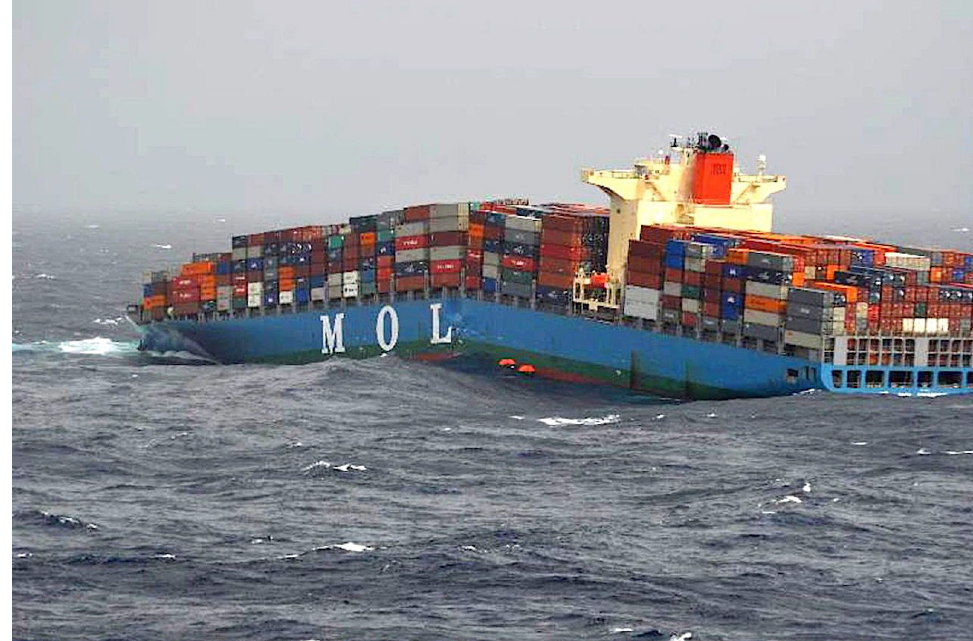
Figure 30. Breakup of the container ship MOL Comfort, off Yemen, in June 2013. Photo from [109] with permission; originally taken by Mitsui O.S.K. Lines, Ltd., Tokyo, Japan.